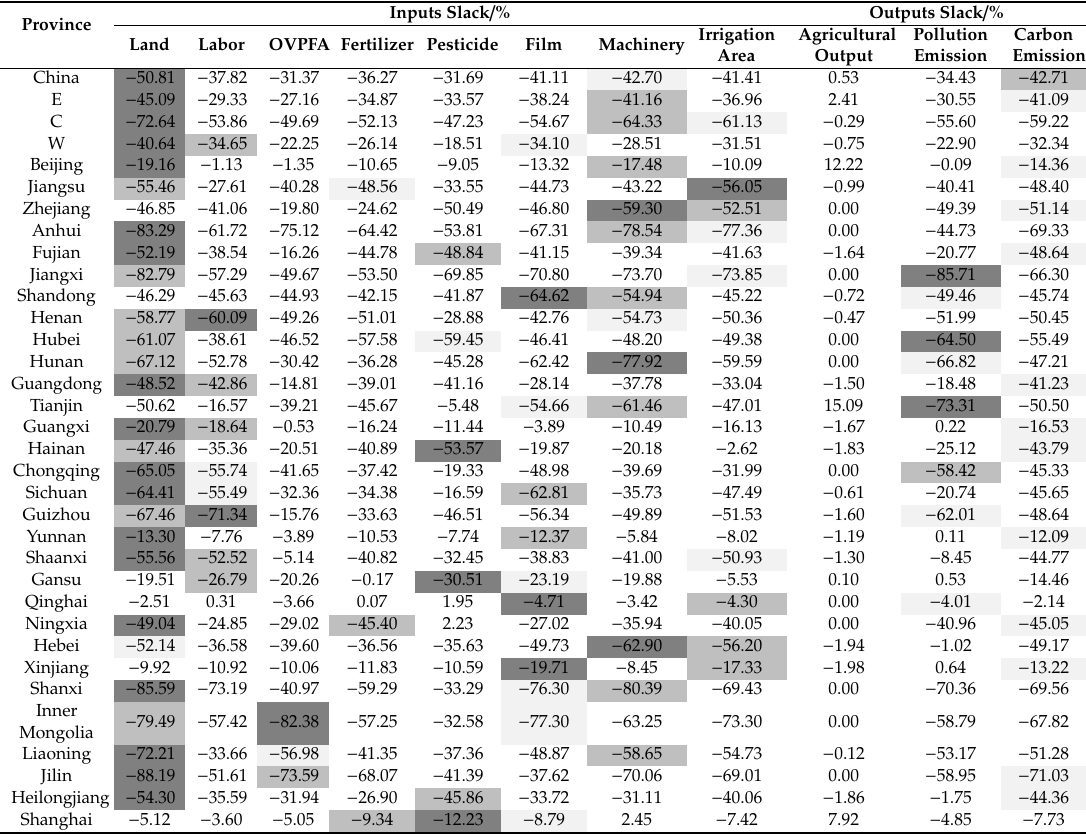
Note: Black represents the factor with the greatest optimization potential in a certain province. Dark gray represents the factor with the second greatest optimization potential, and light gray represents the factor with the third greatest optimization potential. E, C, and W are short for the eastern region, central region and western region,